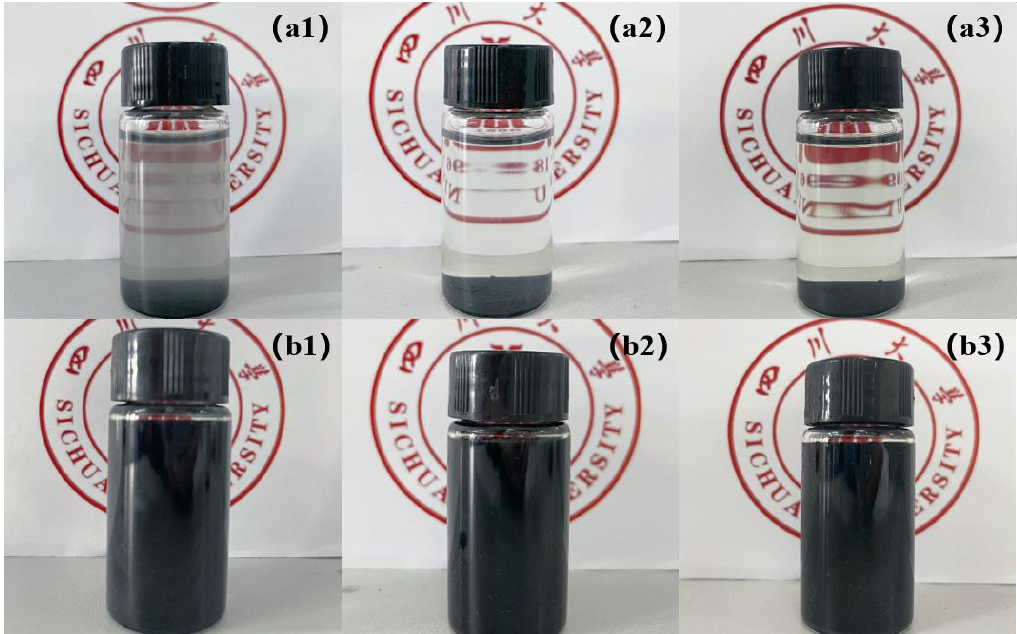
Figure 2. Digital photo of ( a1 – a3 ) Ti 3 AlC 2 and ( b1 – b3 ) Ti 3 C 2 T x dispersed in distilled water on day 1, day 3, and day 7.